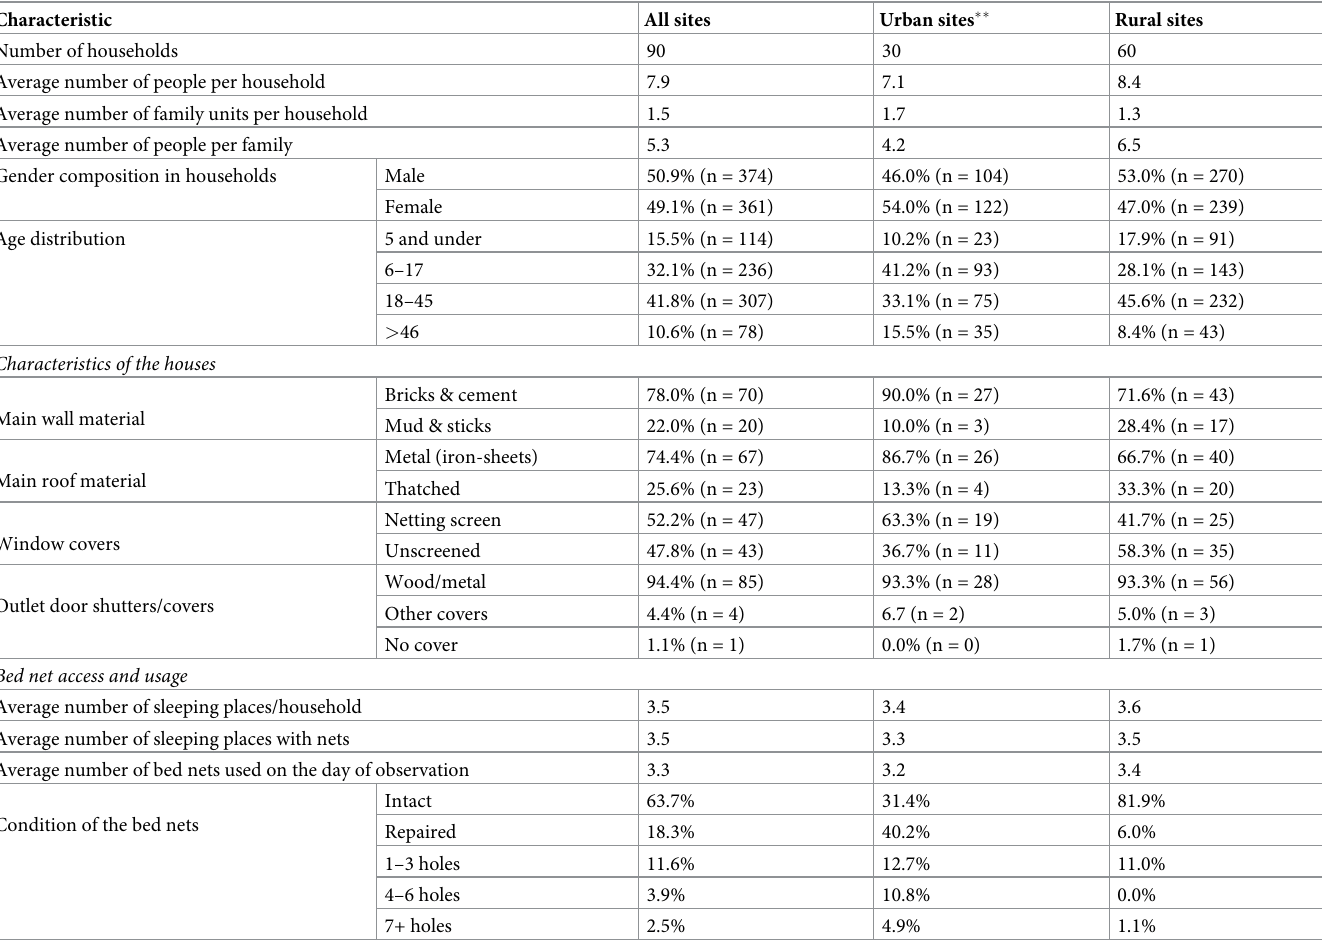
Table 1. Characteristics of the study participants and their houses in the nine study villages in Ulanga and Kilombero districts, south-eastern Tanzania.